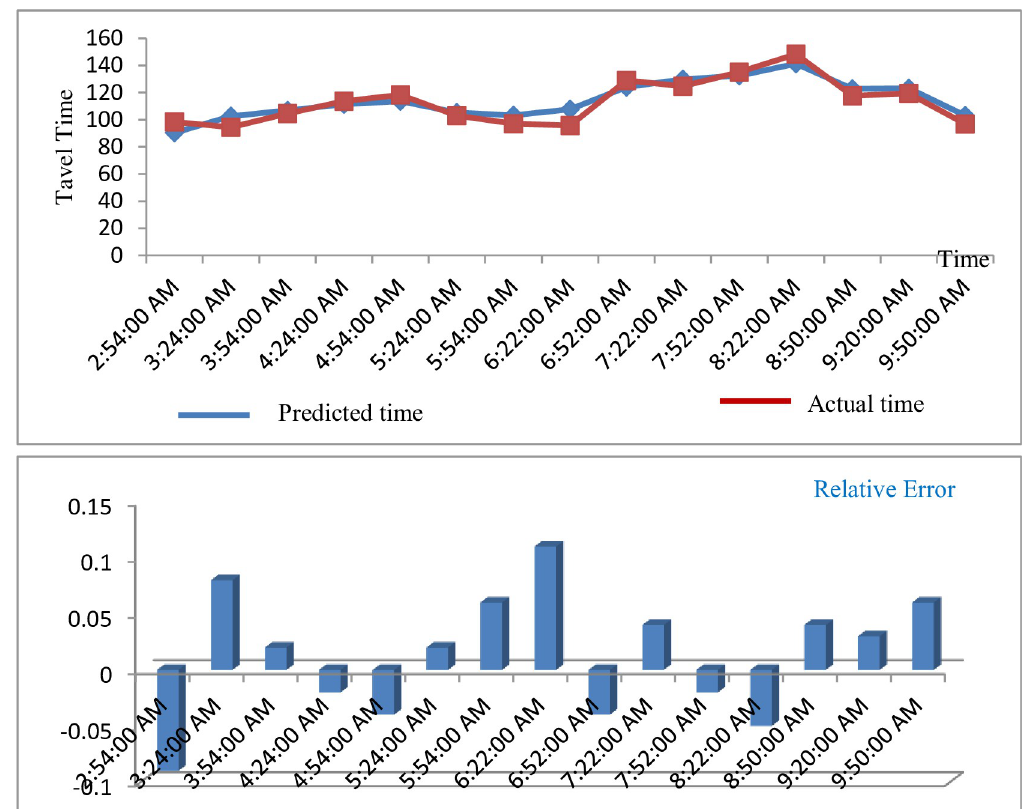
Fig 8. Predicted result of travel time (route segment